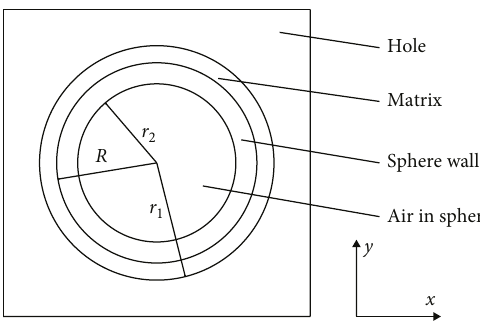
Figure 14: Model of carbon matrix deposit on the